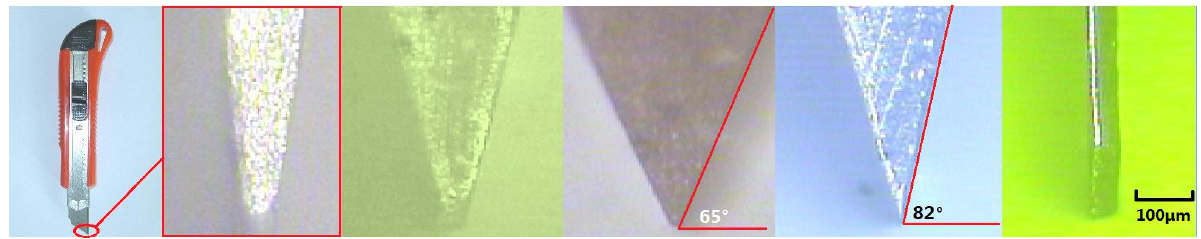
Figure 5. Micrograph of different shapes of the engraving